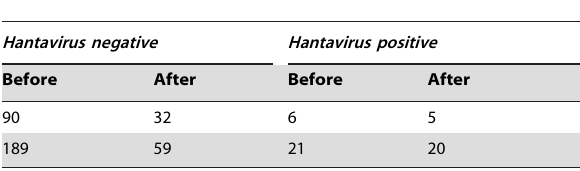
Table 1. Number of seropositive and seronegative individual animals in control (unmanipulated) and experimental (non- reservoirs removed) sites before and after the removal